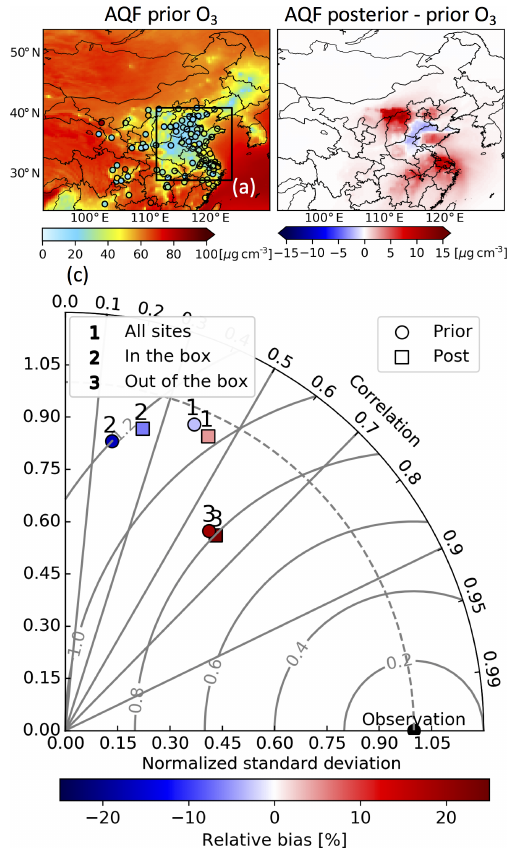
Figure 14. Evaluation of GEOS-Chem surface O 3 forecasts with in situ observations for November 2013. Panel (a) shows AQF-PRI O 3 forecasts with in situ observations overlapped. Panel (b) shows the difference between and AQF-MIX-DE-POS and AQF-PRI O 3 fore- casts. Panel (c) shows the Taylor diagram of evaluations of surface O 3 forecasts in (a) and (b) with in situ observations. Circles and squares represent the AQF-PRI and AQF-MIX-DE-POS forecasts, respectively. Labels 1, 2, and 3 represent that all sites, only sites that are within the black box in (a) , and only sites that are outside of the black box in (a) are used for